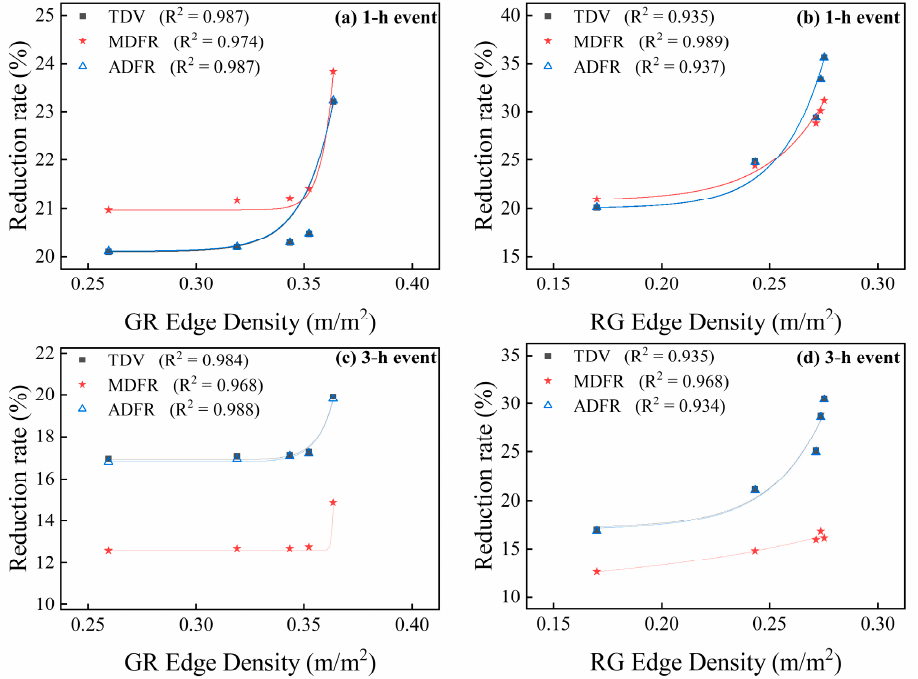
Figure 13. Effect of decentralized level of SuDS components on TDV, ADFR and MDFR: ( a ) GR, in 1 h event; ( b ) RG, in 1 h event; ( c ) GR, in 3 h event; ( d ) RG, in 3 h event.